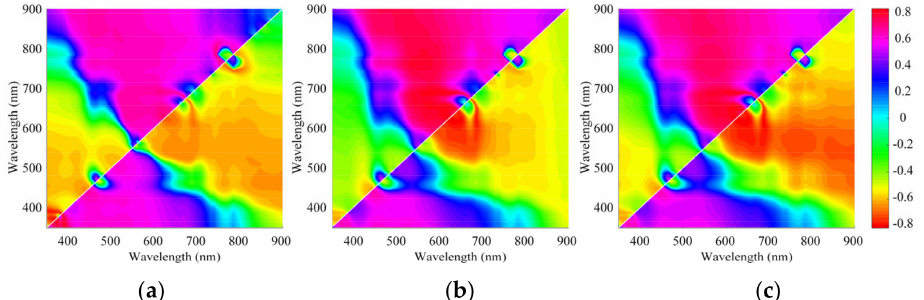
Figure 4. The distribution of correlation coefficient between in situ chl-a and the three specific indexes. ( a ) correlation coefficient between in situ chl-a and R rs ( λ 1 ) − R rs ( λ 2 ) ; ( b ) correlation coefficient between in situ chl-a and R rs ( λ 1 ) / R rs ( λ 2 ) ; and ( c ) correlation coefficient between in situ chl-a and ( R rs ( λ ) − R rs ( λ )) / ( R rs ( λ ) + R rs ( λ )) . 2 3 1 4